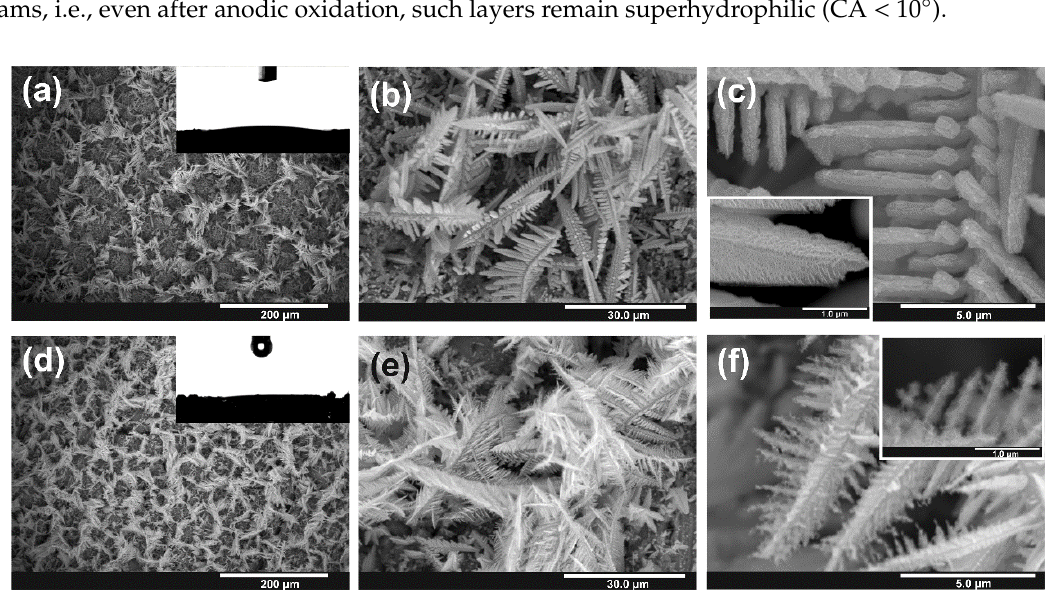
Figure 4. FE-SEM images of anodic Sn/SnOx anodized at 4 V for 600 s ( a – c ), and 1200 s ( d – f ) after annealing in air at 200 °C for 2 h.